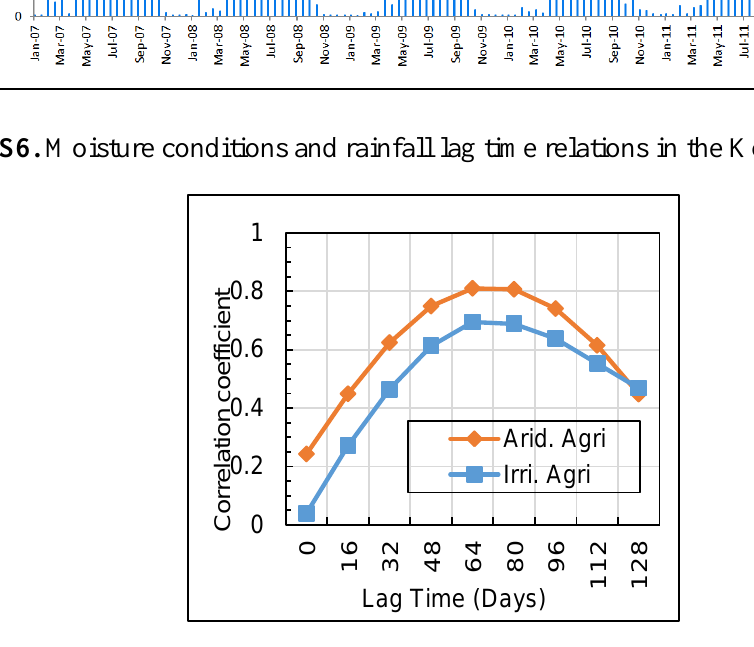
Figure S7. Plots of NRD and SPI time series ( left ), NRD and NVSWI time series ( right